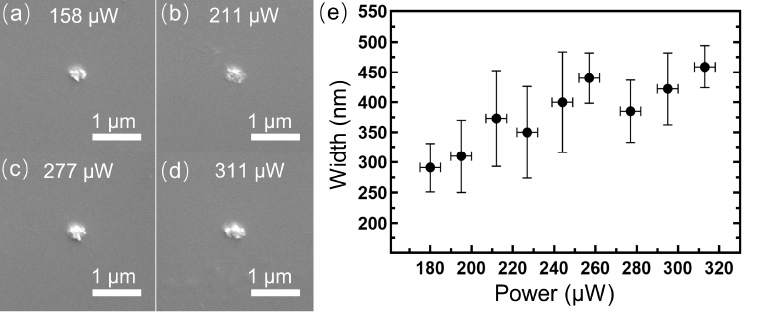
Figure 5. Influence of energy density on the machined feature size with microspheres. ( a – d ) SEM im- ages of silicon substrates irradiated with lasers with powers of 158, 211, 277, and 331 µ W, respectively. ( e ) Width of the oxidation-induced convex silicon oxide structures as a function of laser